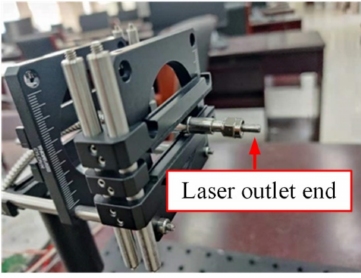
Figure 9. Fiber-coupled semiconductor laser outlet